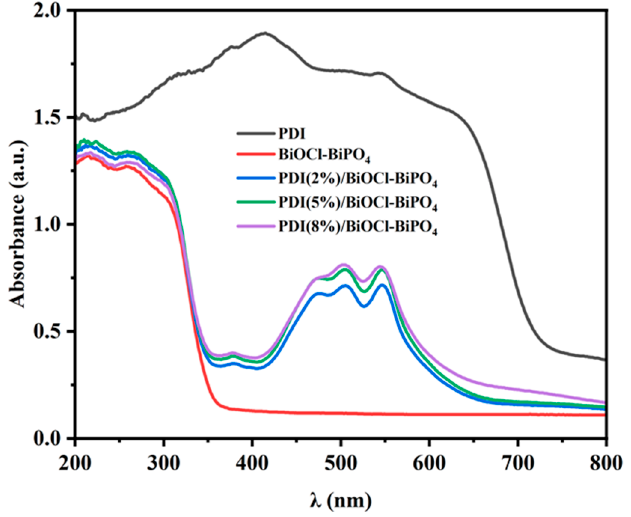
Figure 4. UV-vis DRS spectra of PDI, BiOCl-BiPO 4 , PDI(2%)/BiOCl-BiPO 4 , PDI(5%)/BiOCl-BiPO 4 and PDI(8%)/BiOCl-BiPO 4 samples.